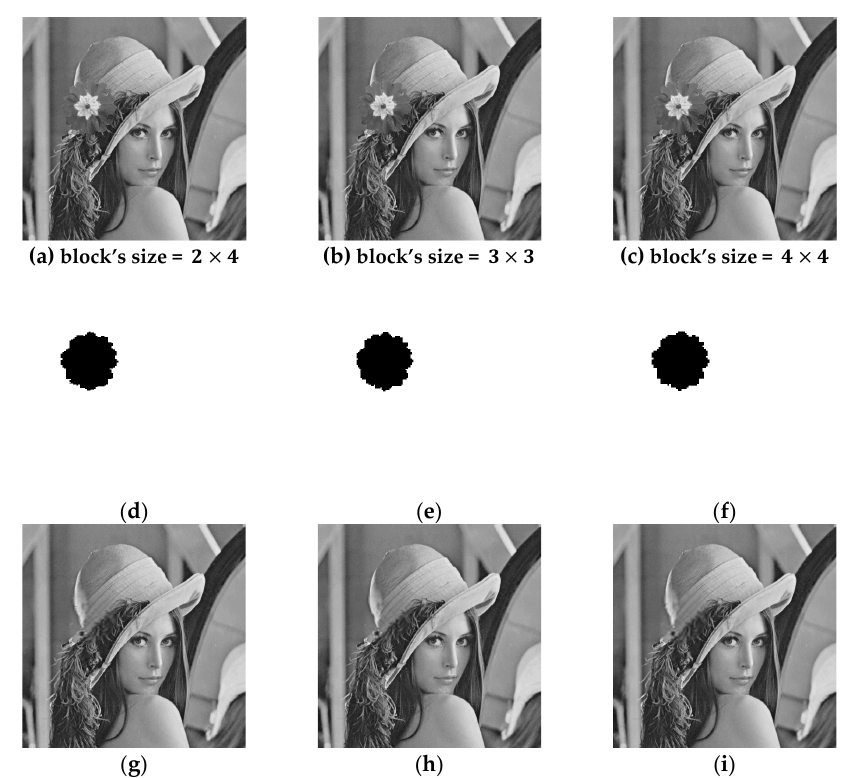
Figure 8. Watermarked Lena and tamper detection results for different block sizes using “block-size detection” ( a )–( c ) Tampered images (tamper rate = 4.4%), ( d )–( f ) tamper detection result, ( g )–( i ) recovery images. Sensors 2019 , 19 , x;